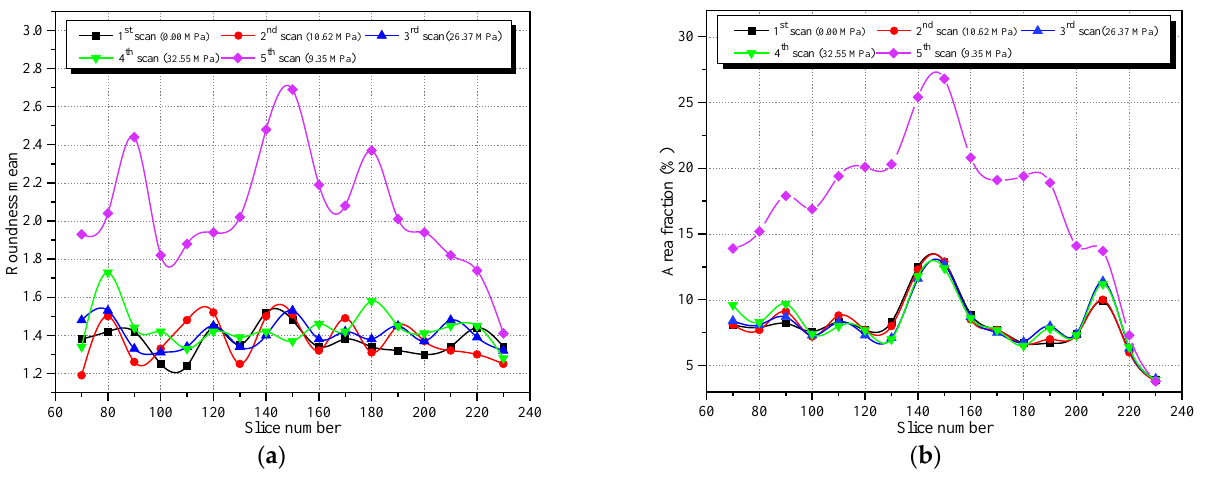
Figure 6. Changes in roundness mean and area fraction of holes and cracks along the height direction of the specimen at different scanning stages, ( a ) Roundness mean, ( b ) Area fraction.